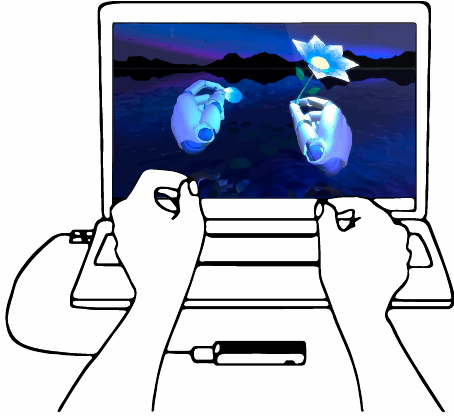
Figure 8. Leap Motion operating mode.